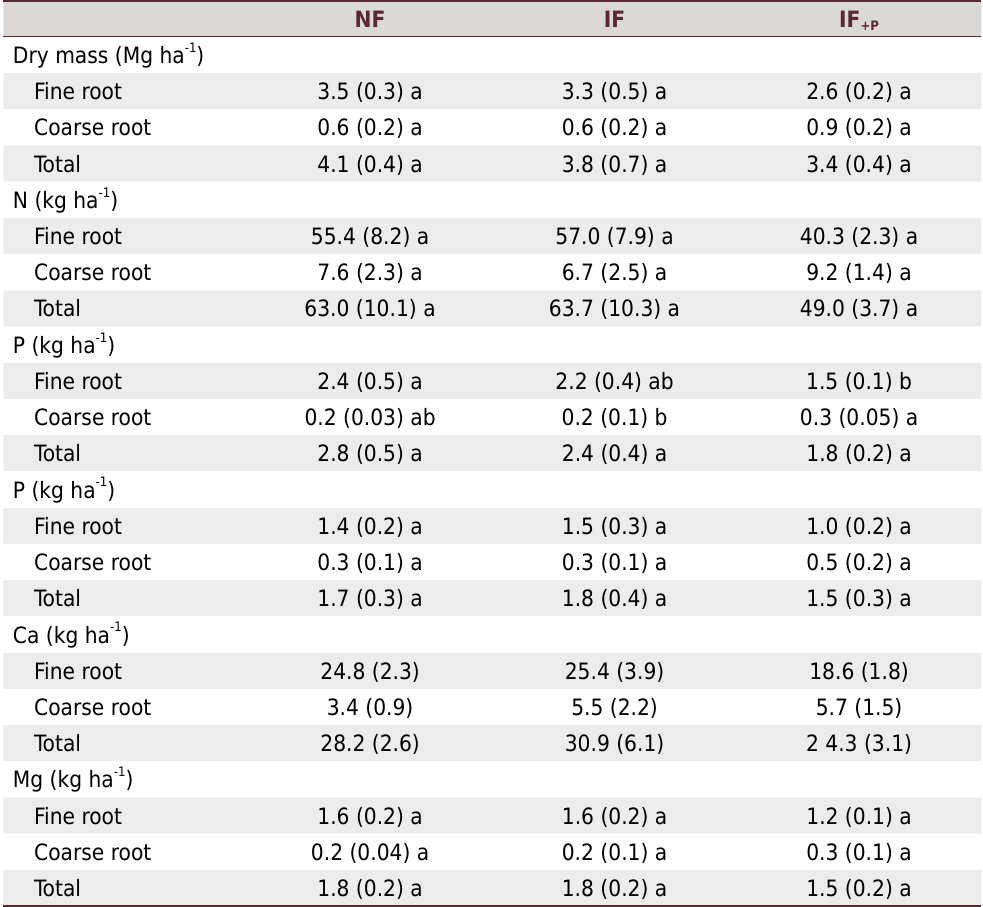
Table 5. Dry mass and nutrient stocks in fine roots (ø ≤ 2 mm) and coarse roots (ø 2.1 to 5 mm) after 23 months of natural fallow (NF), improved fallow (IF), and improved fallow with P fertilization (IF +P ) in Marapanim, eastern